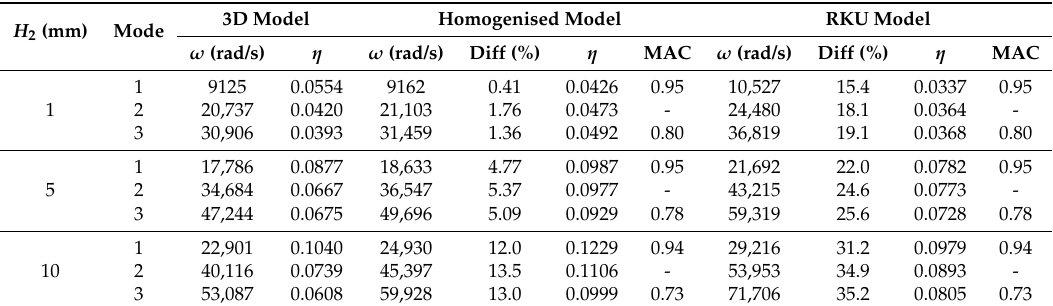
Table 4. Natural frequencies and loss factors of the simply supported CLD plate computed with the three models. For the plate models, the percent difference in natural frequency and MAC values in comparison to the 3D model are shown. The MAC value is omitted for double modes.